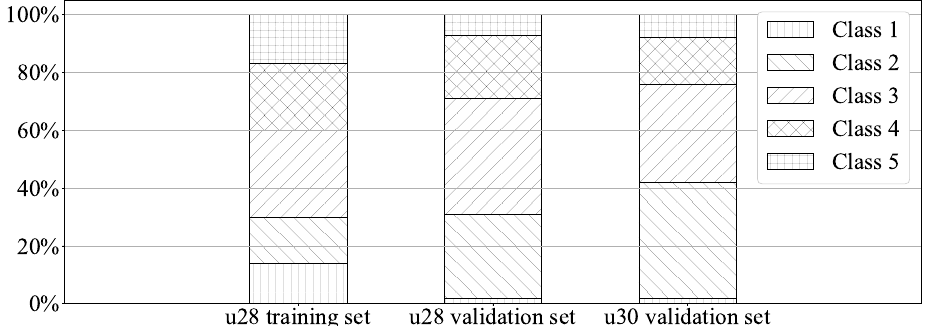
Figure 5. Percentage ratio of the traces to each of the functional road classes in terms of length.